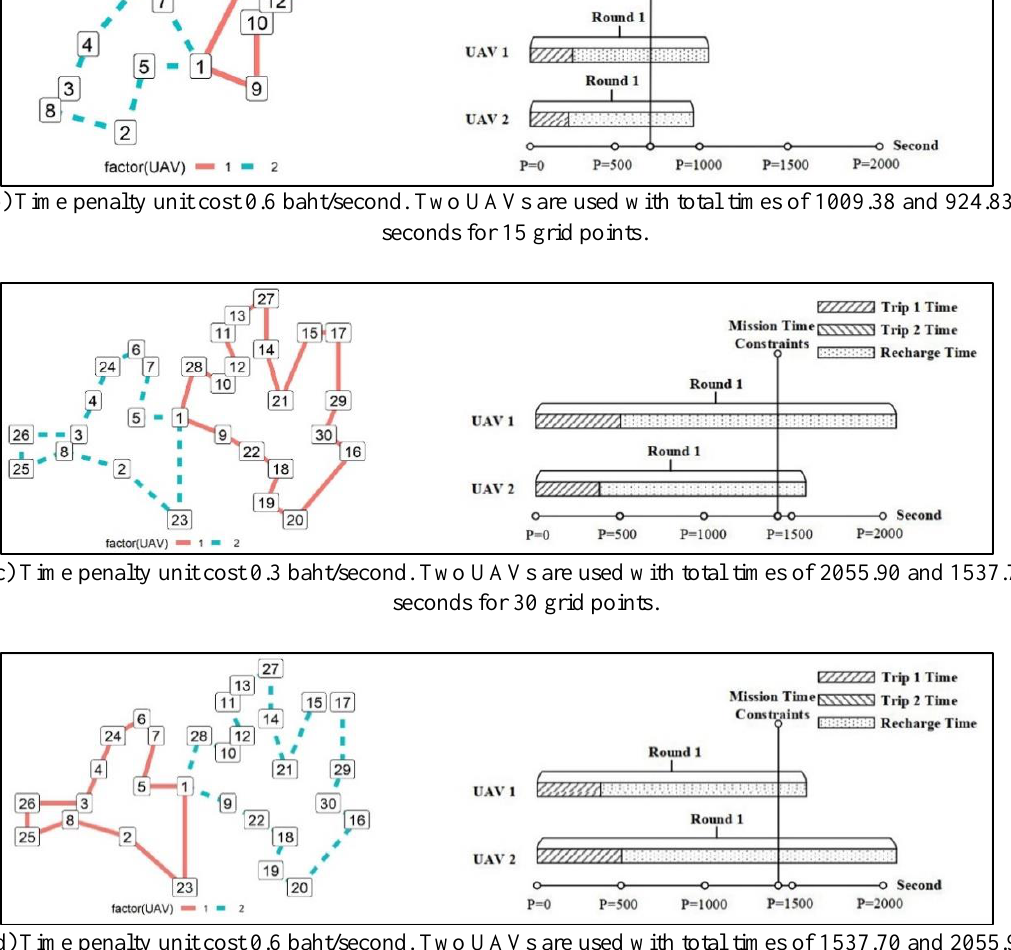
Figure 5. Flying paths and timing diagrams for the real terrain